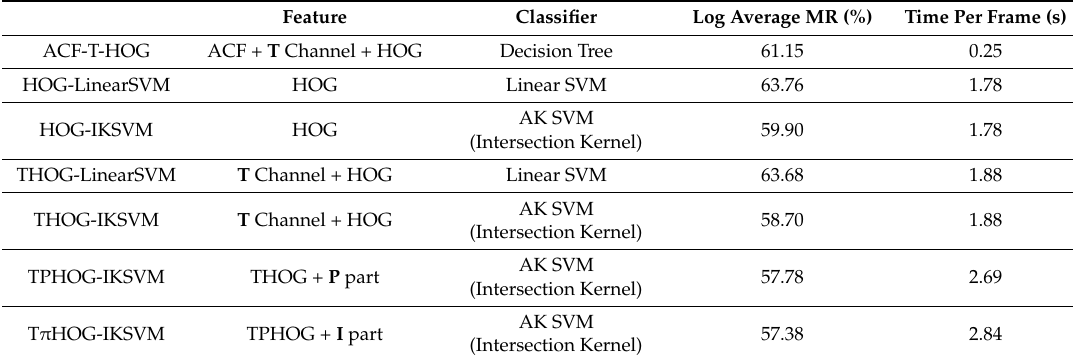
Table 2. Detailed information of feature-classifier.